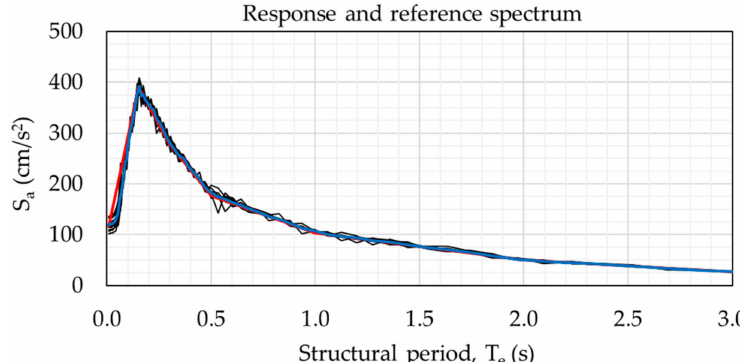
Figure 7. Response and reference spectra comparison for the city of Puebla, Mexico. Step 2: Use the soil layers data from the site to perform the transfer function and obtain the dynamic amplification of the